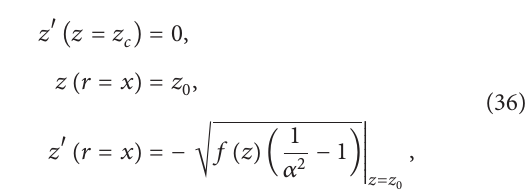
The holographic pair production rate is